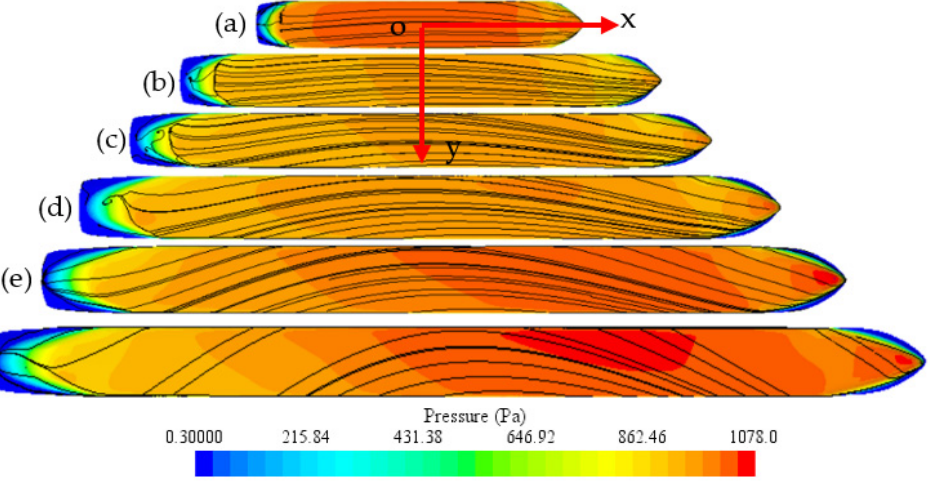
Figure 16. Pressure contours with streamlines of ship type variation. ( a – f ): L pp = 1.54 m, 2.68 m, 3.6 m, 4.4 m, 5.4 m, 7.2 m corresponding beam = 0.202 m, 0.328 m, 0.38 m, 0.45 m, 0.45 m, 0.45 m.